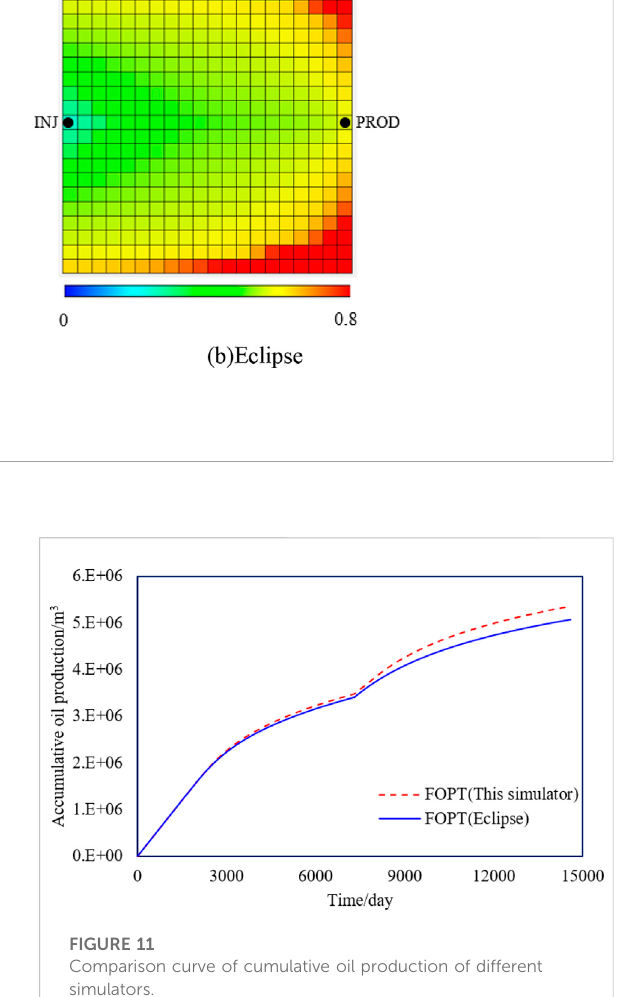
FIGURE 10 Comparison curves of oil production rate and water cut of different simulators.